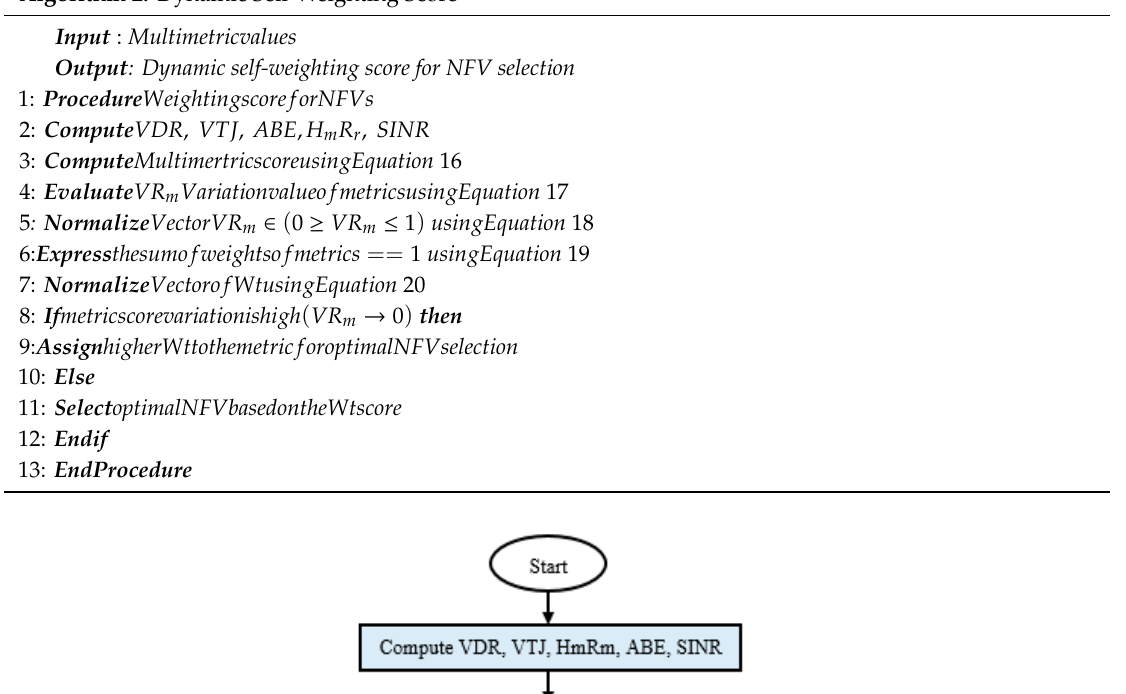
Algorithm 2. Dynamic Self-Weighting Score